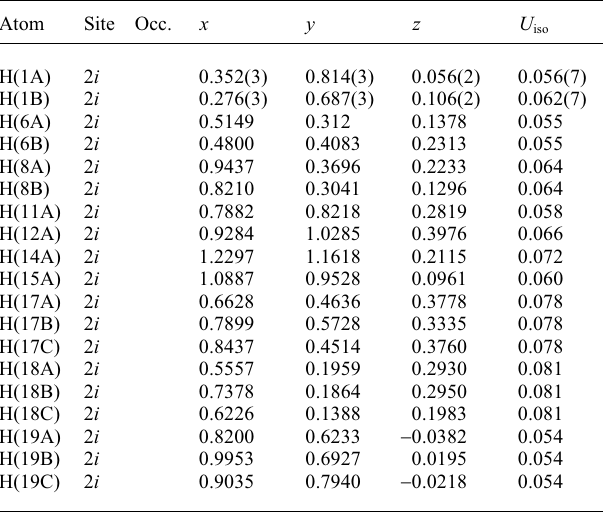
Table 2. Atomic coordinates and displacement parameters (in Å 2 ) . Atom Site